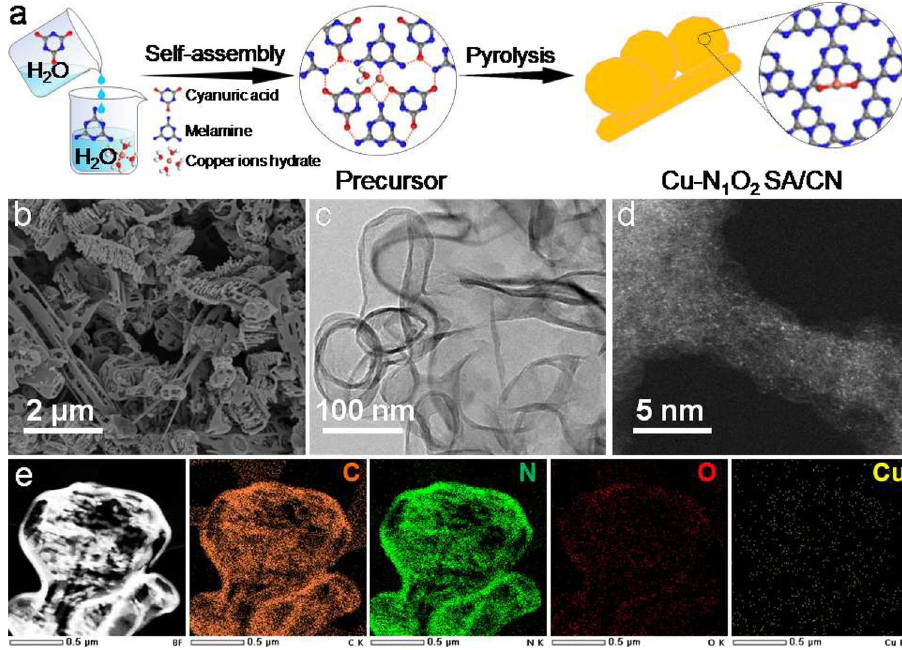
Fig.1|Samplesynthesisandmorphologycharacterizations.a SchematicillustrationofpreparationofCu-N 1 O 2 SA/CN. b SEMimage, c HR-TEMimage, d HAADF-STEM image and e the local EDX elemental mappings of Cu-N 1 O 2